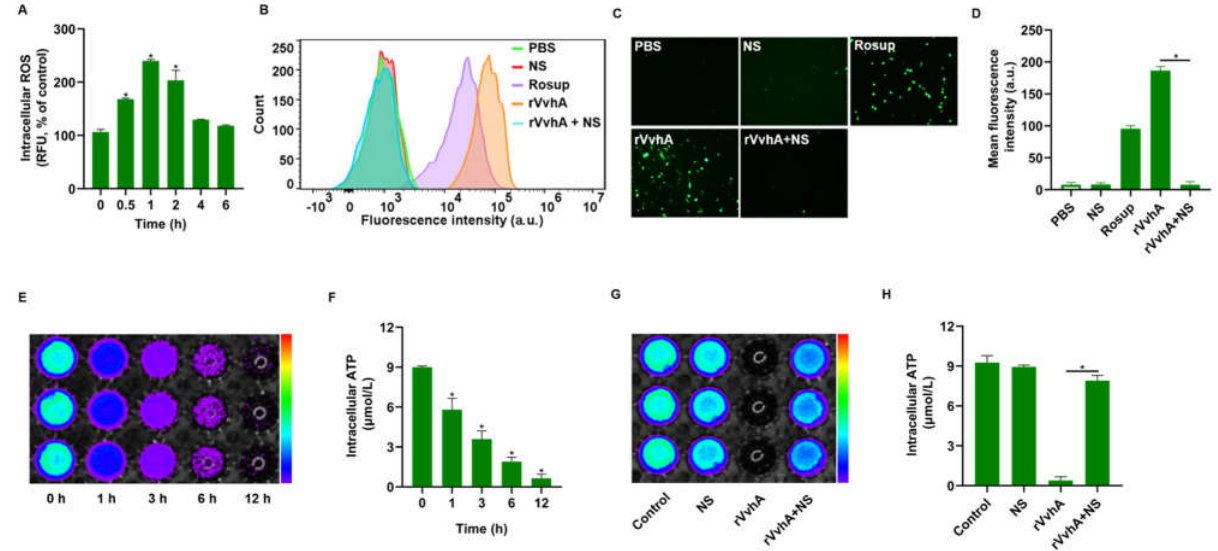
Figure 3. Inhibitory effects of NSs on rVvhA-induced ROS production and ATP reduction in HPAECs. ( A ) Time response of ROS production in HPAECs treated with rVvhA (500 ng/mL). ( B ) Flow cytometry results showing ROS production in HPAECs with various treatments. ( C ) ROS production (green) was visualized by fluorescence microscopy in HPAECs treated with PBS, NSs (40 μg/mL), rVvhA (500 ng/mL), rVvhA (500 ng/mL) plus NSs (40 μg/mL), respectively. (Original magnification × 200). ( D ) The quantification of ROS production in ( C ). ( E , F ) Time response of ATP levels in rVvhA-stimulated cells over a period of 12 h (0, 1, 3, 6, 12 h) were examined by a luminometer and bioluminescence imaging. ( G , H ) Analysis of ATP levels for 12 h in HPAECs treated with PBS, NSs (40 μg/mL), rVvhA (500 ng/mL), rVvhA (500 ng/mL) plus NSs (40 μg/mL), respectively, as detected by a luminometer and bioluminescence imaging. (The data represent the means ± SE. n = 3. * p < 0.05) .